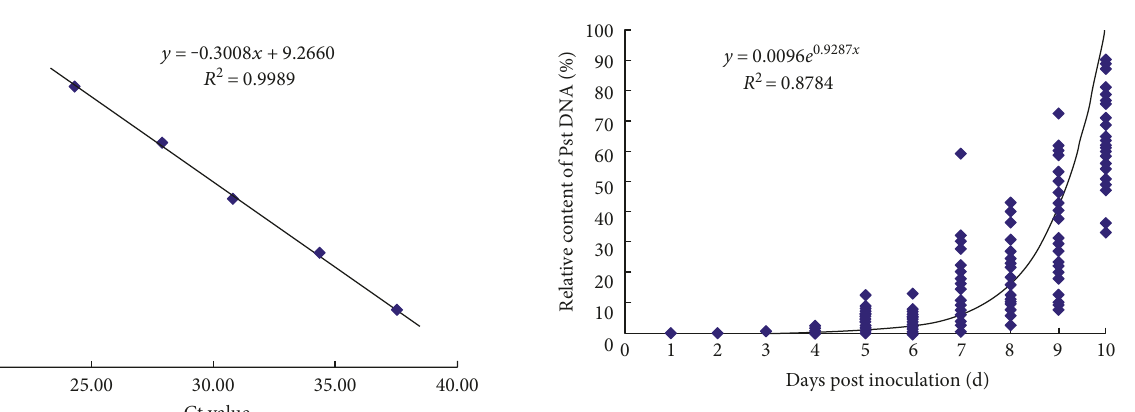
Figure 5: The daily changes of the relative contents of Pst DNA in wheat leaves after inoculation. y = 0.4036 x + 0.9861 R 2 = 0.8750